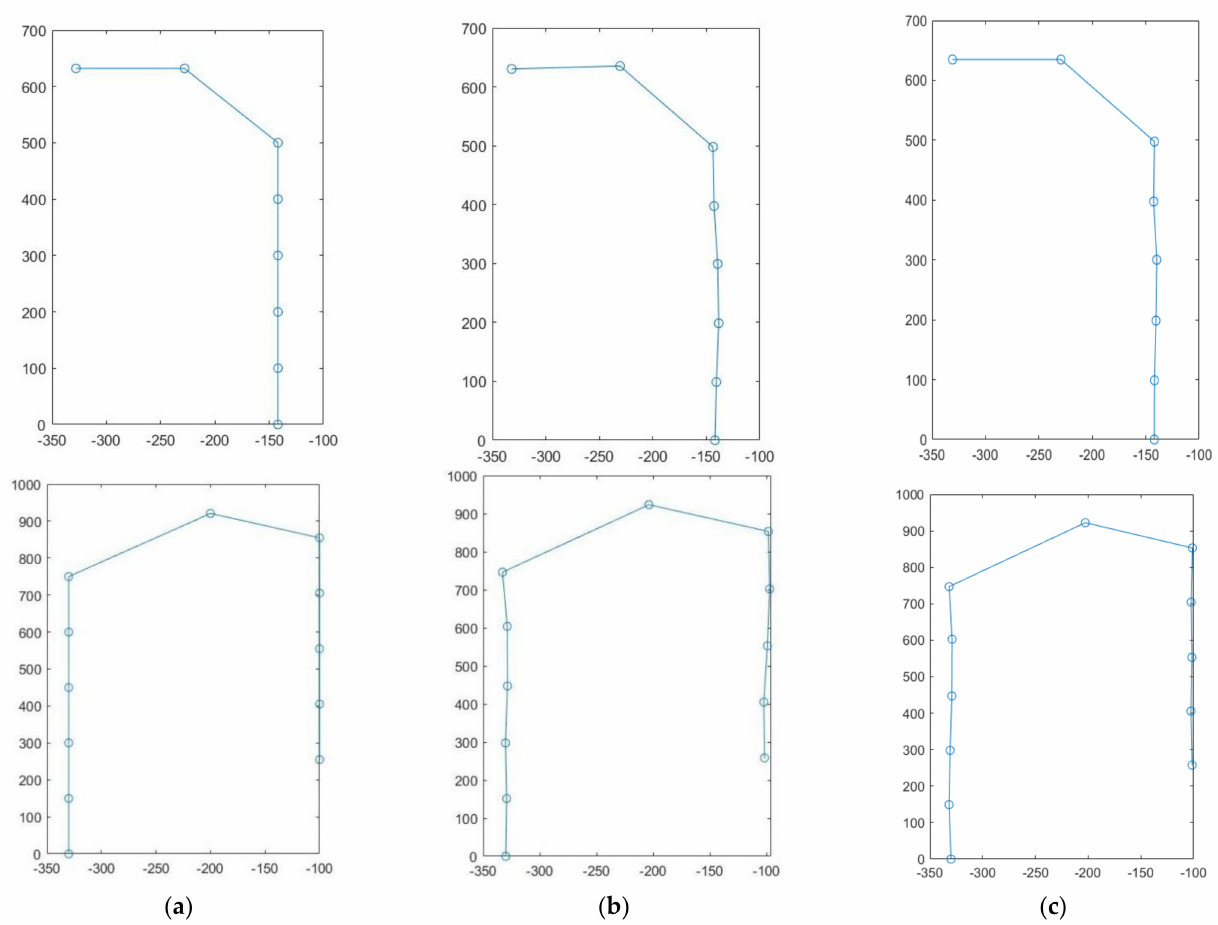
Figure 18. Scatter plot of cruise test for specific operational paths. ( a ) Scatterplot of target expecta- tions, ( b ) Scatter Chart of Traditional Algorithms for Actual Testing, ( c ) Scatter Chart of Improved Algorithms for Actual